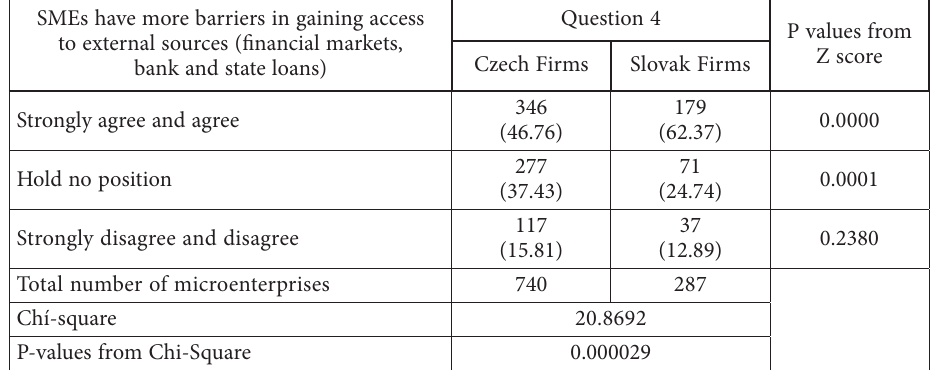
Table 5. Differences in the perception of constraints from external sources (source: own processing) SMEs have more barriers in gaining access to external sources (financial markets, bank and state